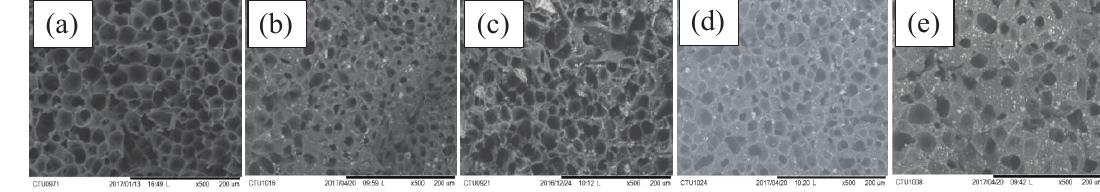
Figure 8: SEM images of scaffolds prepared in different HA contents: (a) 0%, (b) 5%, (c) 10%, (d) 15%, (e) 20%.